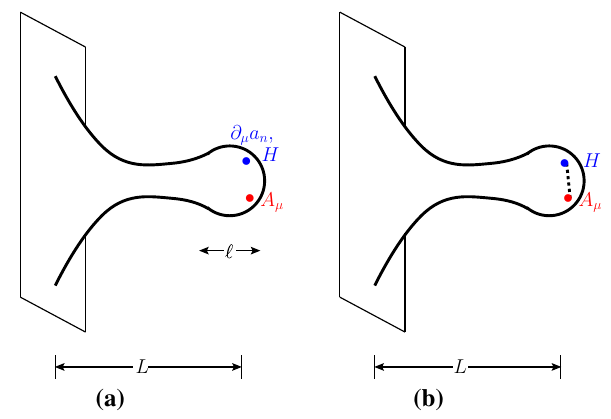
Fig. 1 Compactification,leadingto M 4 × K .Theparallelogramdepicts M 4 , (cid:11) is a compactification size of K and L in one direction is shown pictorially as a